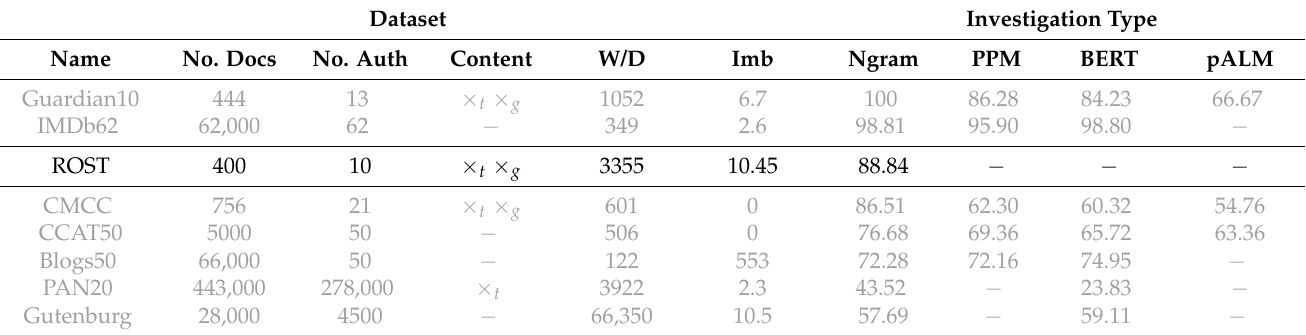
Table 21. State of the art macro-accuracy of authorship attribution models. Information